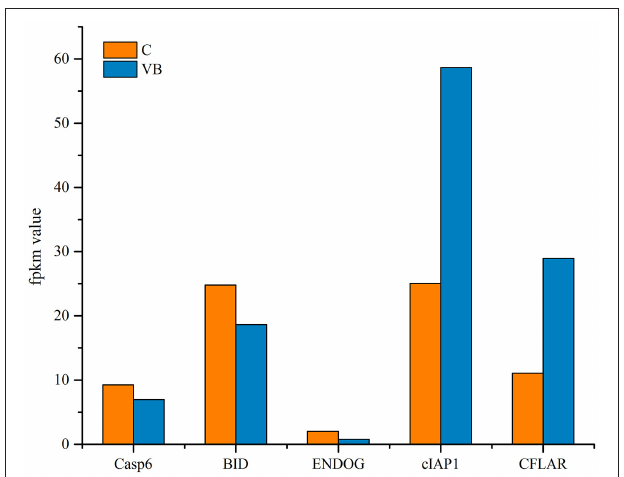
FIGURE 15 | Target genes related to apoptosis.